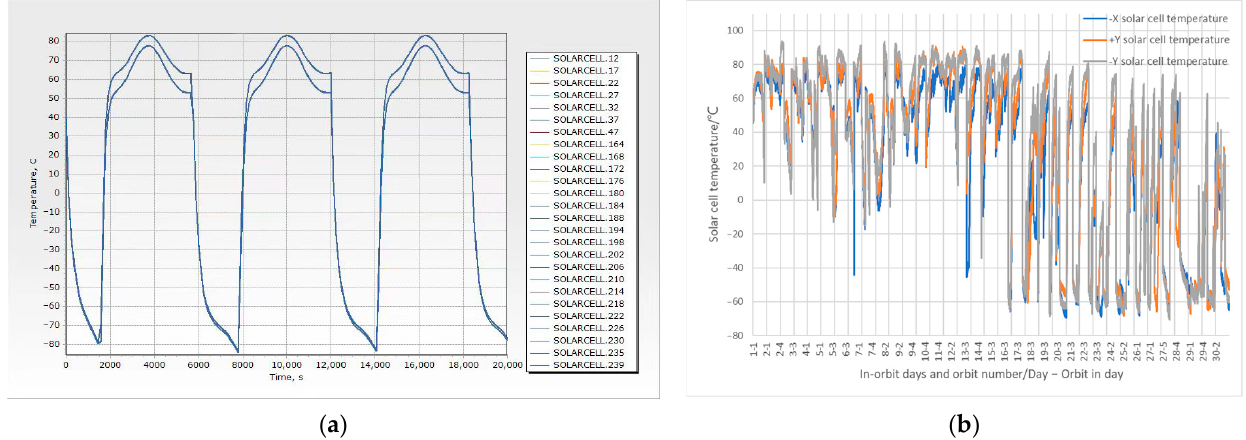
Figure 1. ( a ) Simulated satellite solar cell temperature. ( b ) In-orbit satellite solar cell temperature for 1 month. X-axis shows days of operation and orbit number in a day. Table 1. Solar cell